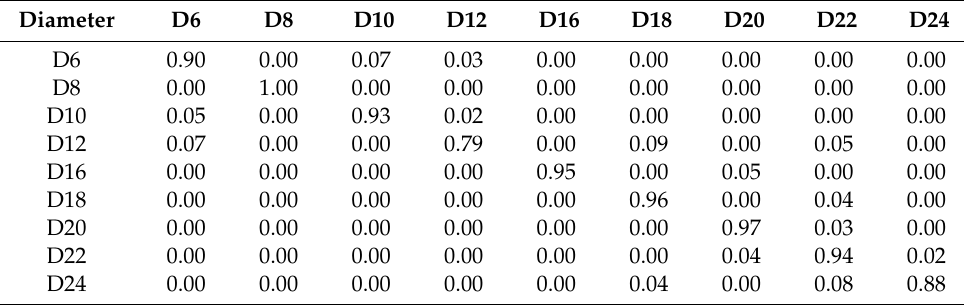
Table 3. Confusion matrix obtained by CNN-LSTM on field datasets.